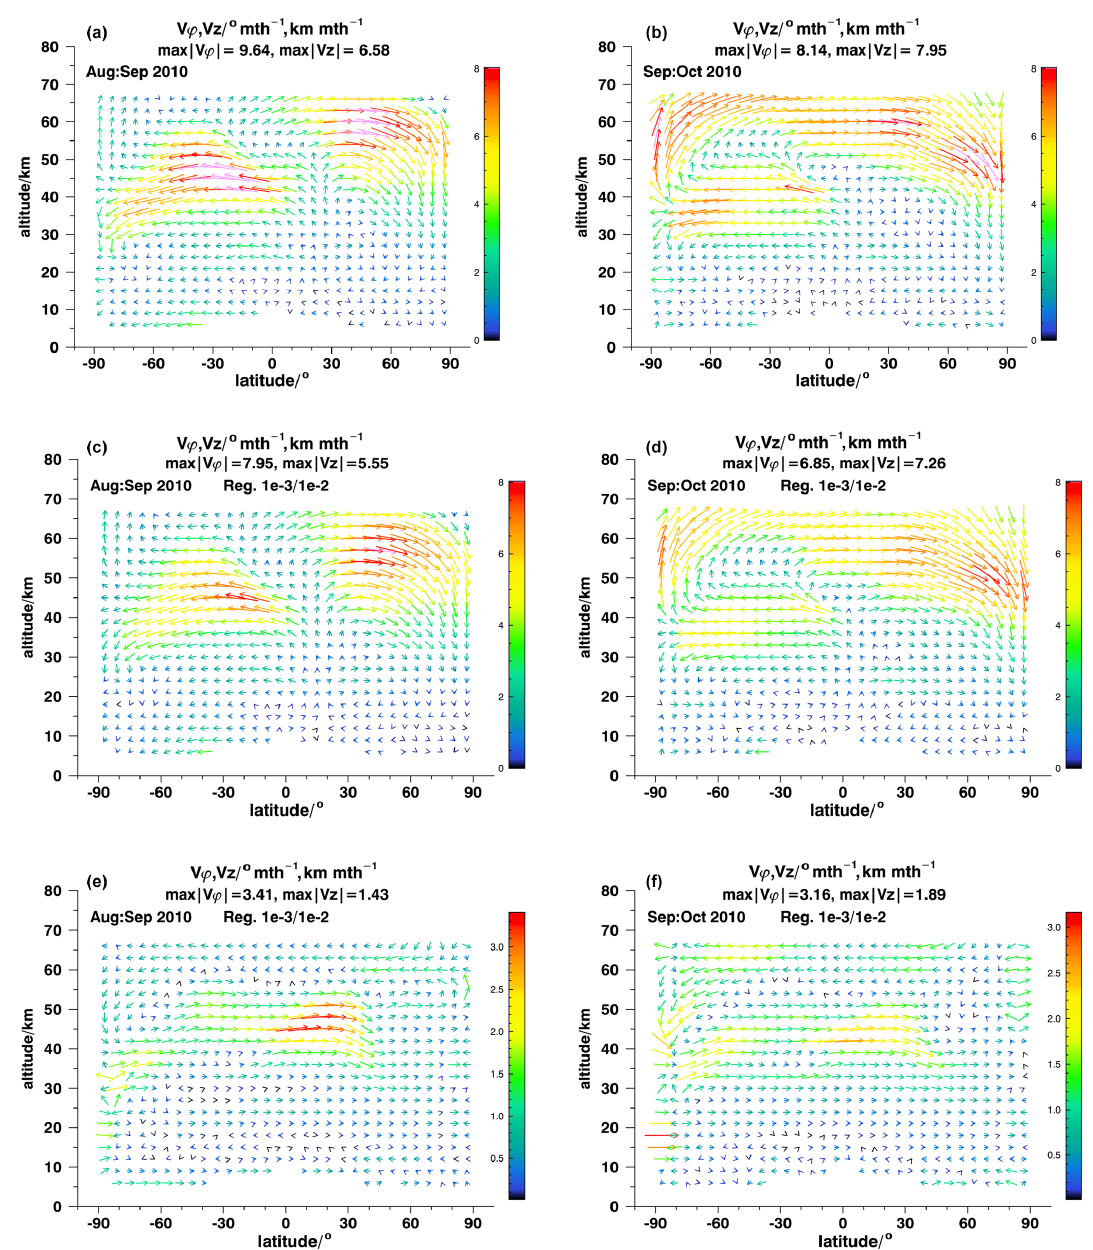
Figure 4. Model recovery tests for August–September 2010 (a, c, e) and September–October 2010 (b, d, f) . For details, see Fig.